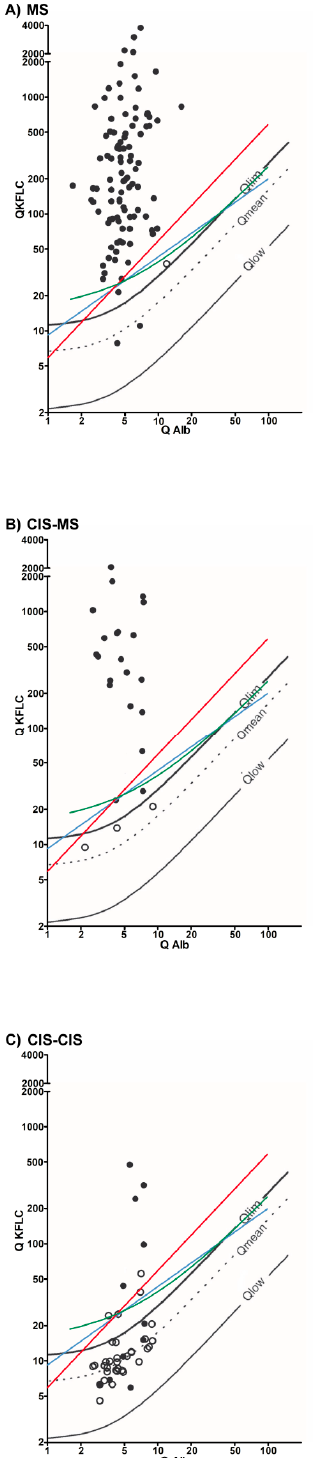
Figure 1. Oligoclonal bands and KFLC synthesis. The black lines represent Reiber’s diagram for KFLC, the blue lines Presslauer’s KFLC exponential curve, the green lines Senel’s linear function, and the red lines the linear KFLC index of 5.9. Black dots are patients with positive oligoclonal bands while black circles are oligoclonal band negative patients. Dots above the threshold lines represent positive patients for the used method. Depicted are patients who were diagnosed with MS according to the McDonald criteria of 2017 ( A ), CIS and conversion to MS during follow-up ( B ), and CIS with a stable disease course during follow-up ( C